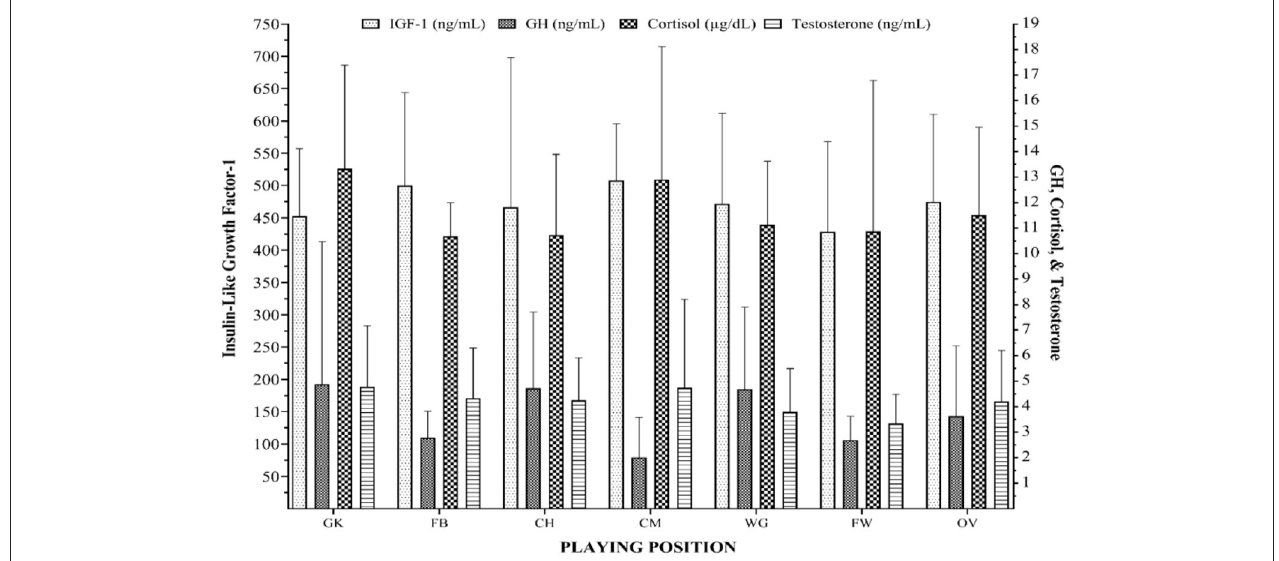
FIGURE 2 | Levels of endocrine markers of soccer players according to playing position and the overall of team after matches of season. GK, goalkeepers; FW, forwards; CM, center-midfielder; CH, center-half; FB, fullback; WG, winger; IGF-1, insulin-like growth factor-1; GH, growth hormone.